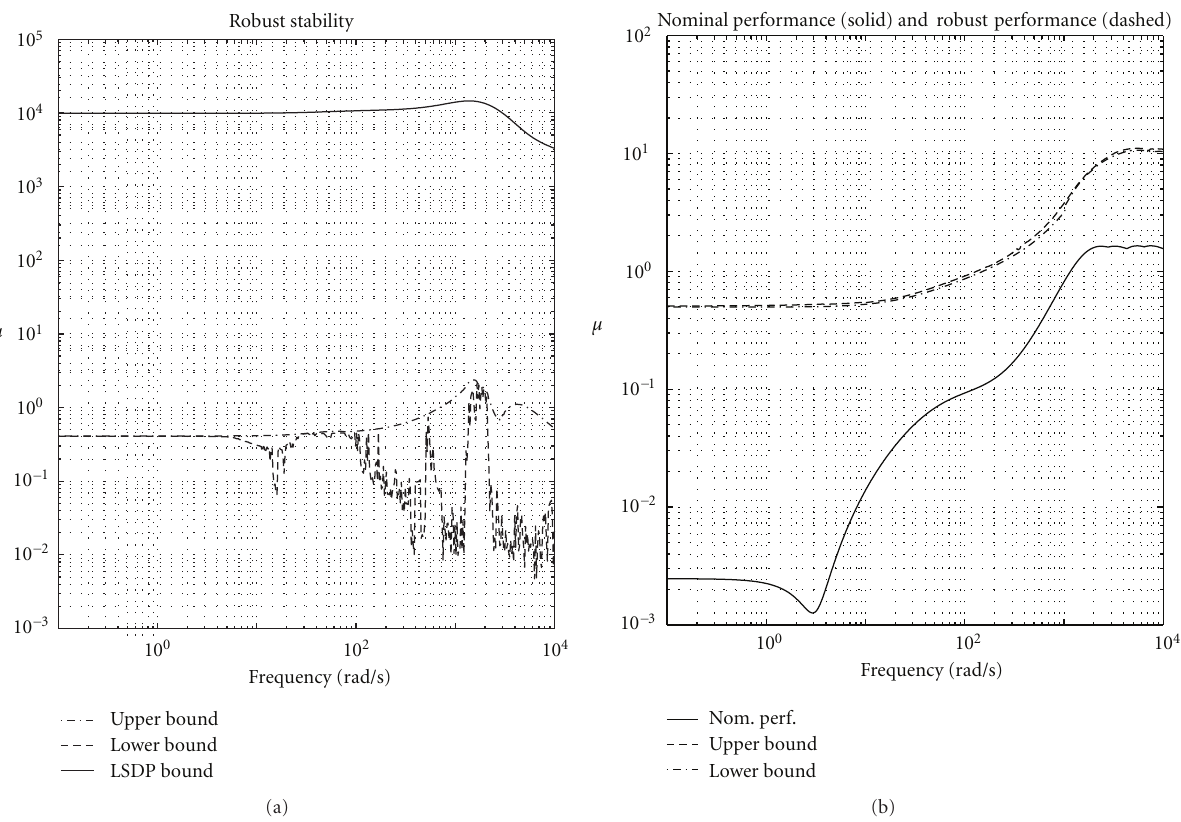
Figure 7: Robust stability, nominal and robust performance function described by μ value with LSDP